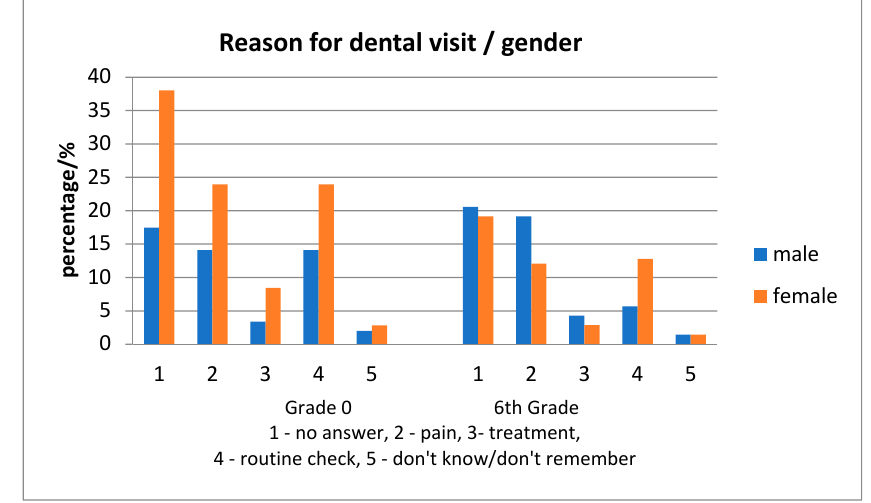
Figure 5. Differences in the reason for visits in the dental office for the last year, according to Figure 5. Di ff erences in the reason for visits in the dental o ffi ce for the last year, according to gender. gender.